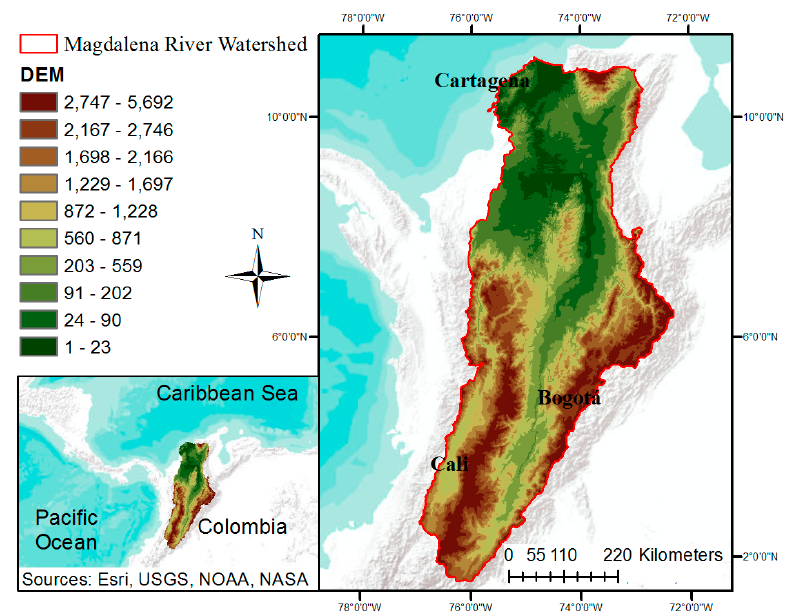
Figure 1. Study site identification of the Magdalena Watershed in Colombia, demonstrating its geographical location, elevation diversity, and presence of larger populated urban environments.